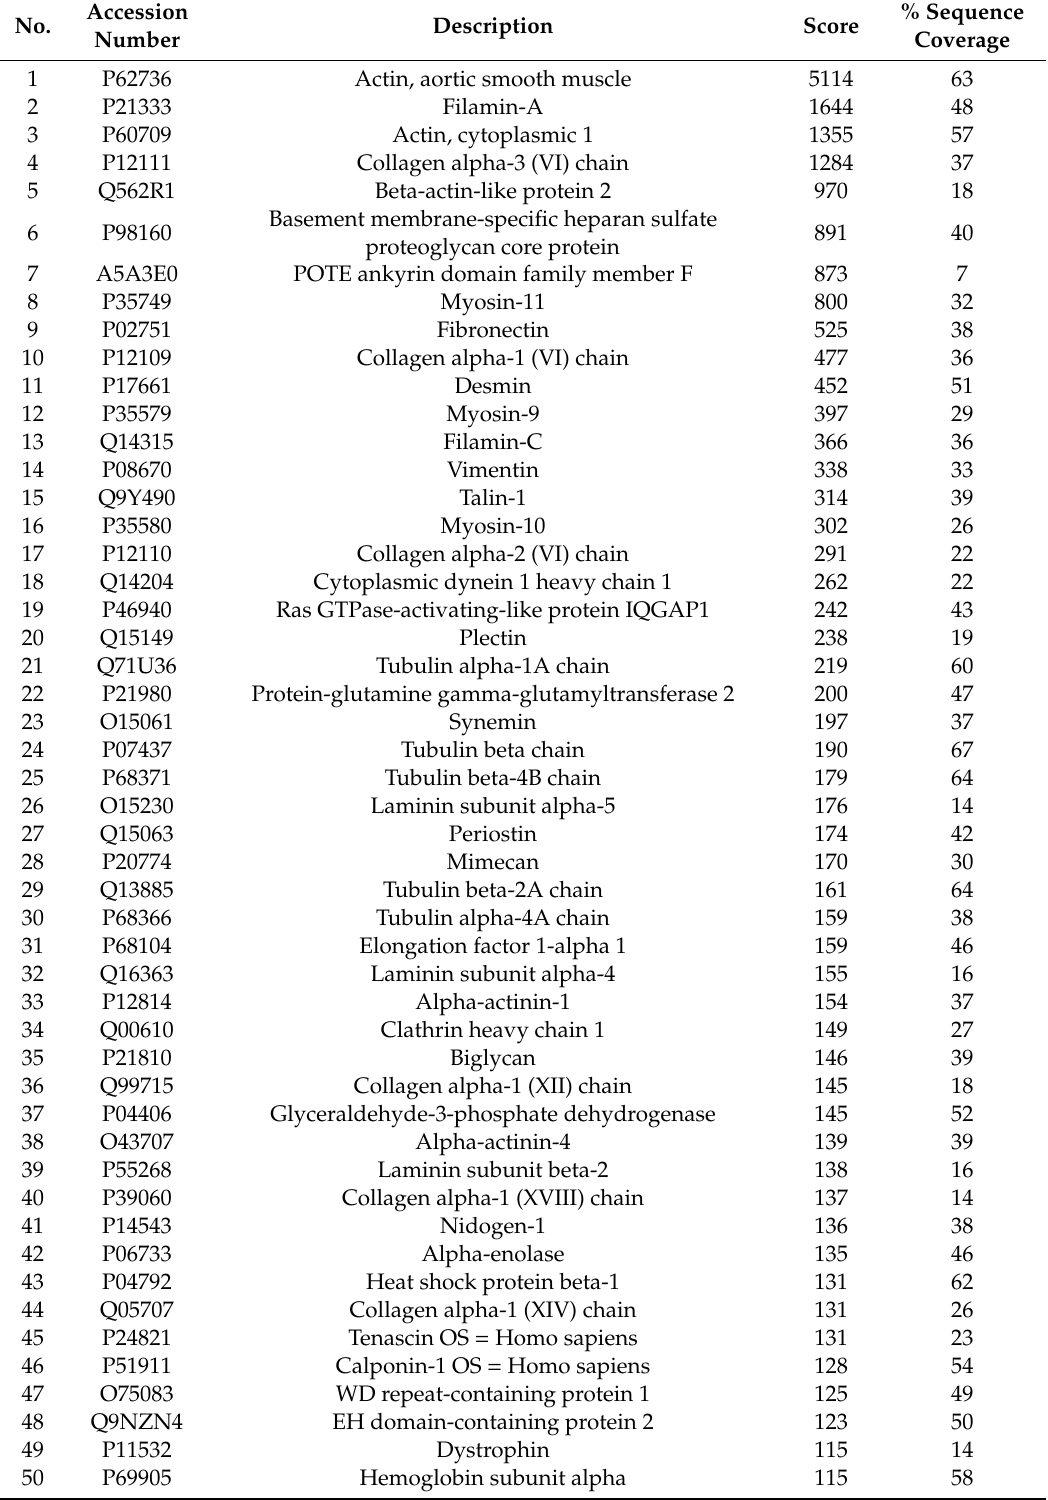
Table 2. List of representative identified proteins in decellularized